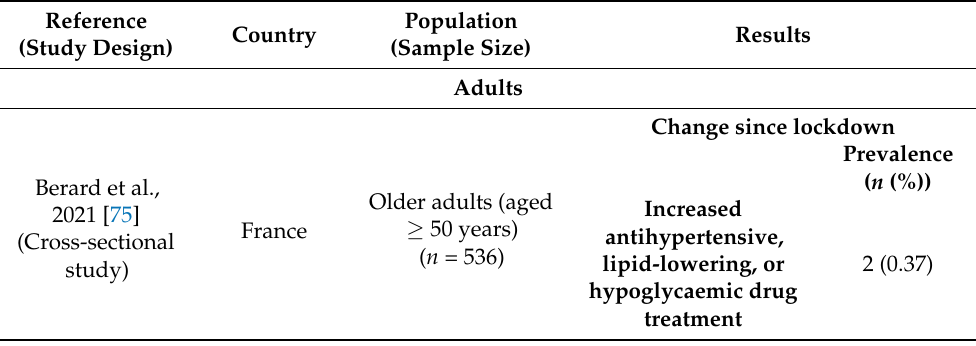
Table 10. Results on Antihypertensive/lipid-lowering/hypoglycaemic